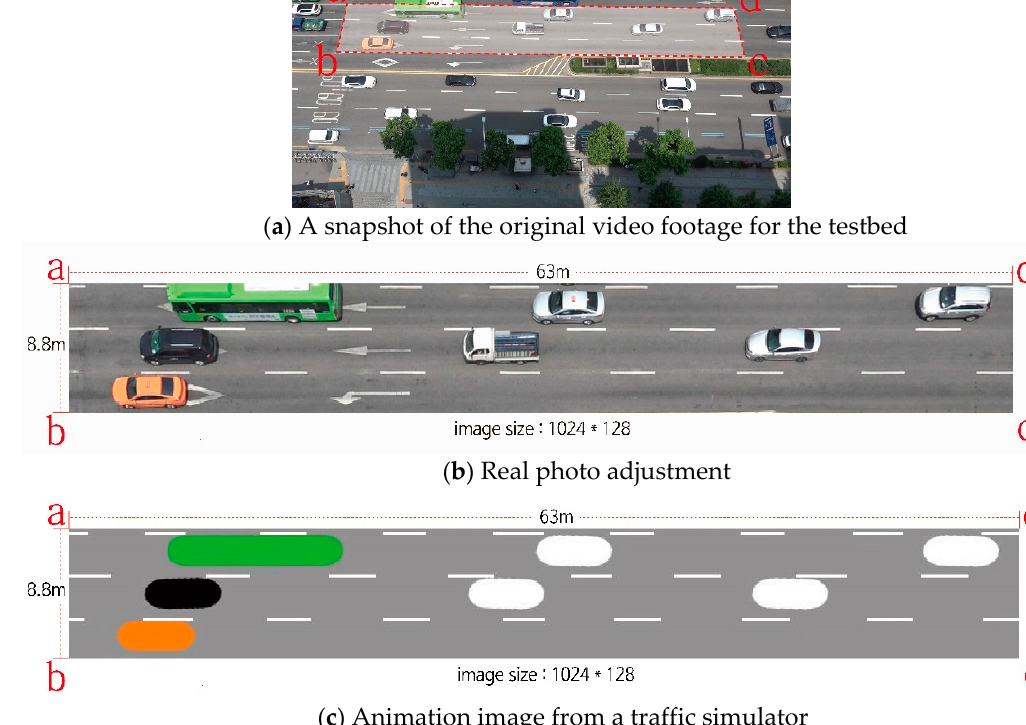
Figure 6. Real photo adjustment and animation image generation.